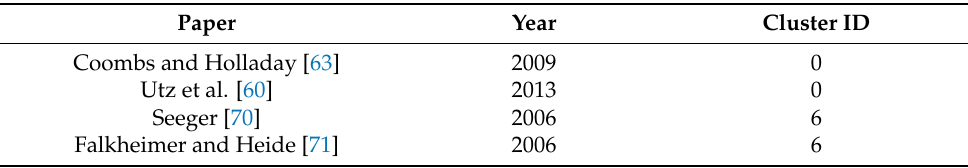
Table 9. Turning points for crisis and risk communication research.